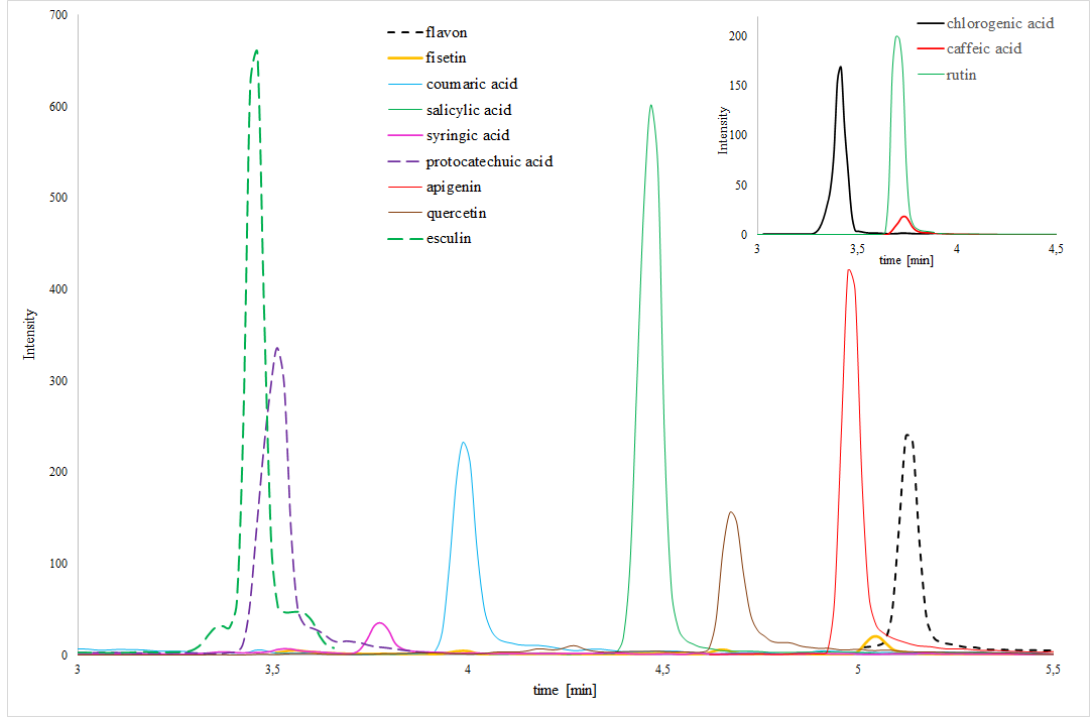
Figure 2. HPLC-MS/MS chromatograms of selected main compounds from yerba mate EA-SFE Figure 2. HPLC-MS / MS chromatograms of selected main compounds from yerba mate EA-SFE extract.